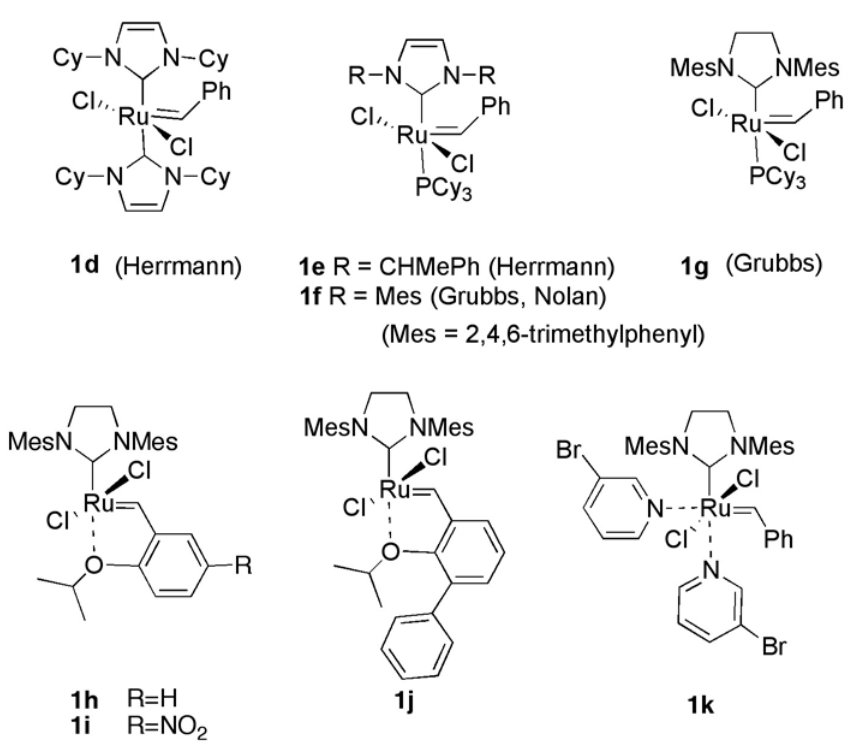
Figure 2. Ruthemium catalysts for alkene